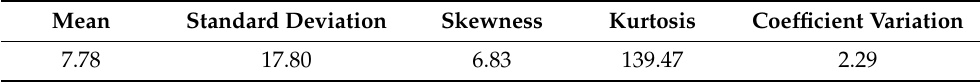
Table 2. Summary statistics of average daily torrential rainfall amounts (mm) for 48 stations.